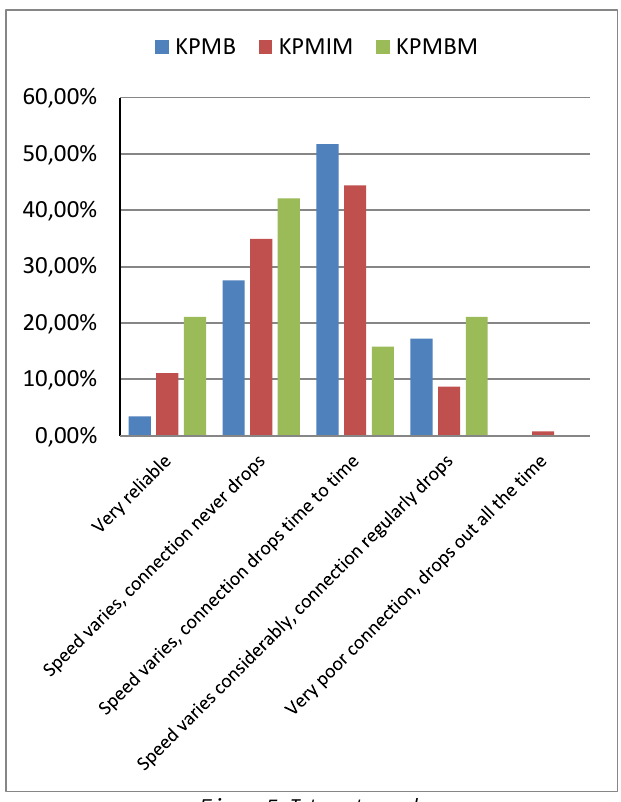
Figure 5. Internet